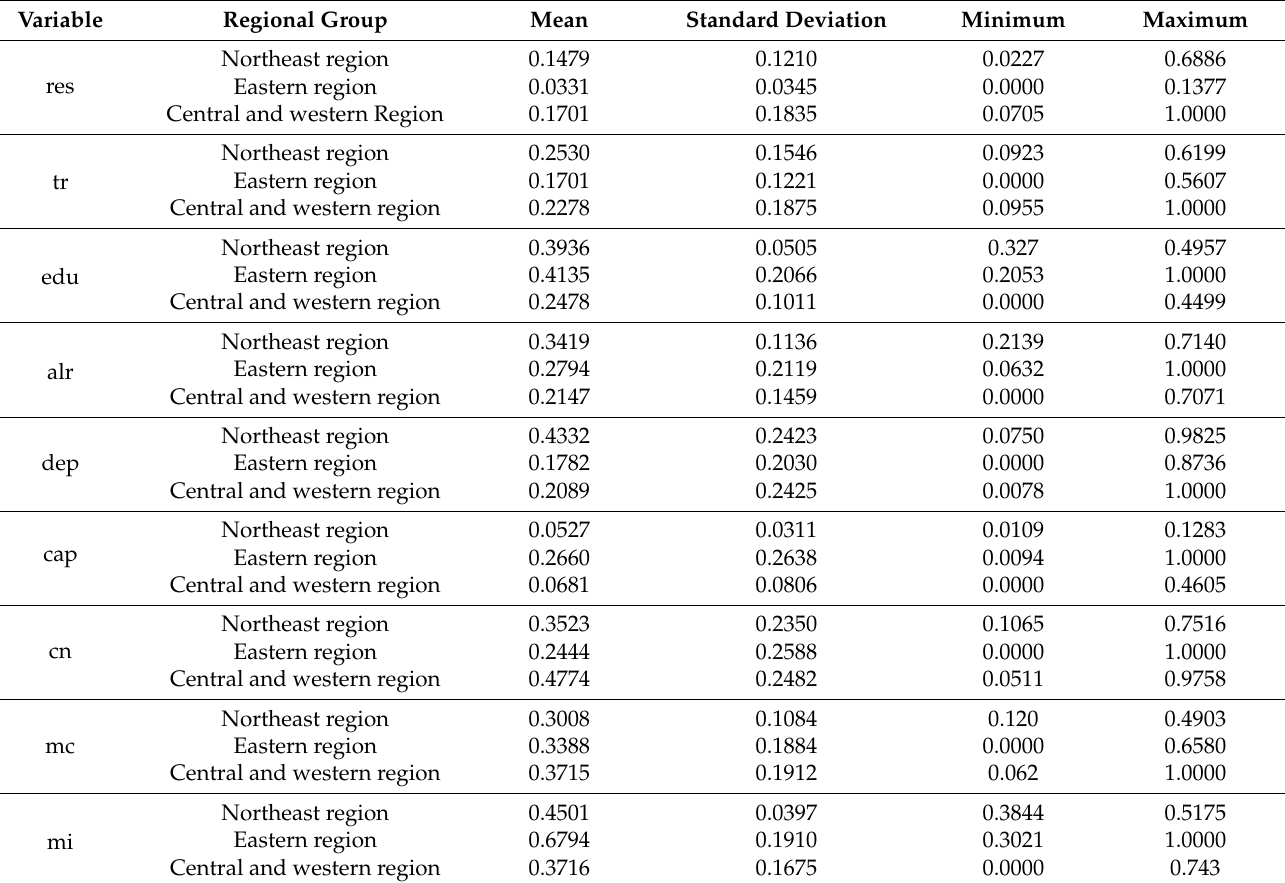
Table 3. Descriptive statistics of the barrier factor